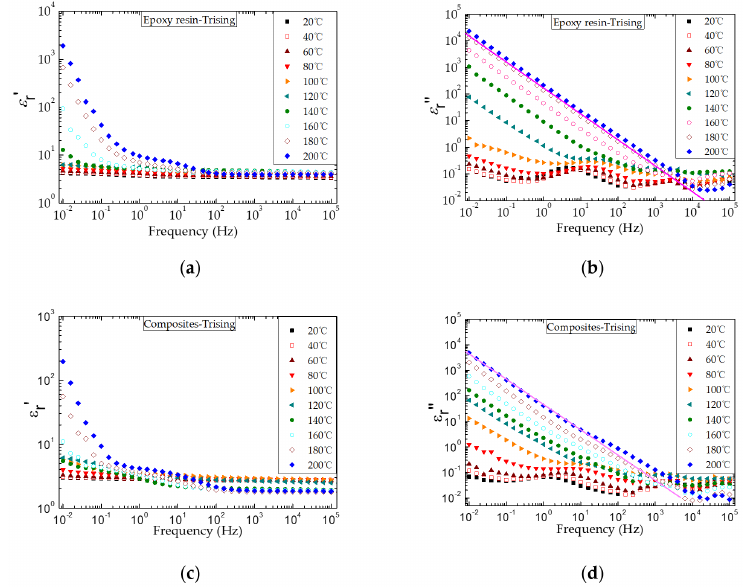
Figure 9. Real part (ε r ′) and imaginary part (ε r ″ ) of the complex permittivity of epoxy resin ( a , b ) and the composite ( c , d ) at different temperatures.